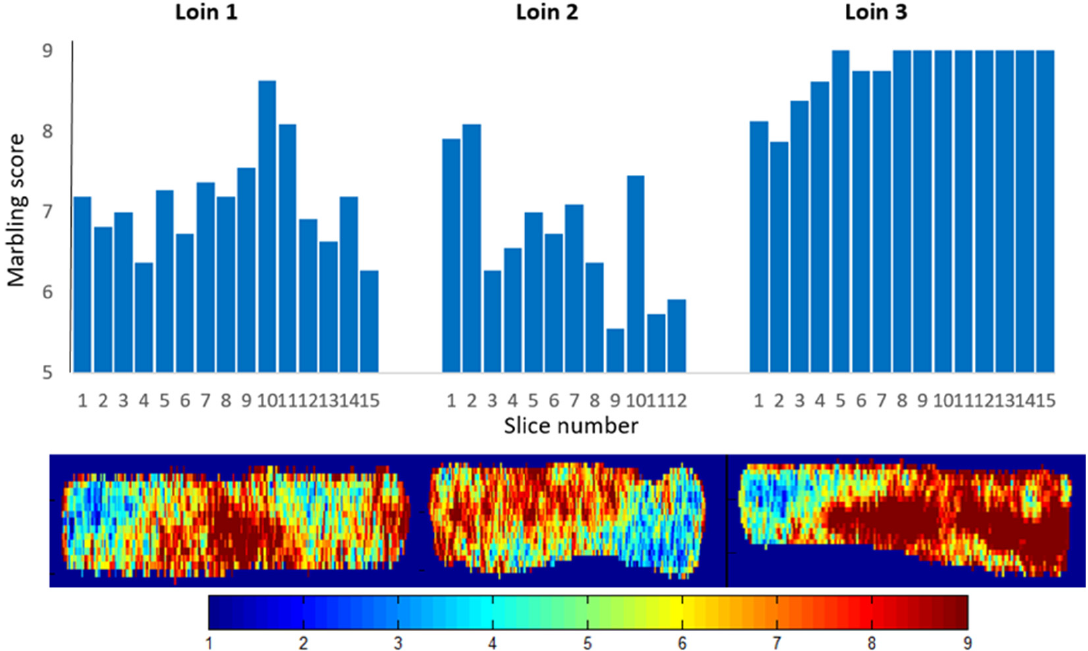
Figure 8. Images of estimated fat marbling in entire loins aligned with sensory assessed marbling in slices from the same loins. Colorbar indicates predicted marbling scores at pixel level.